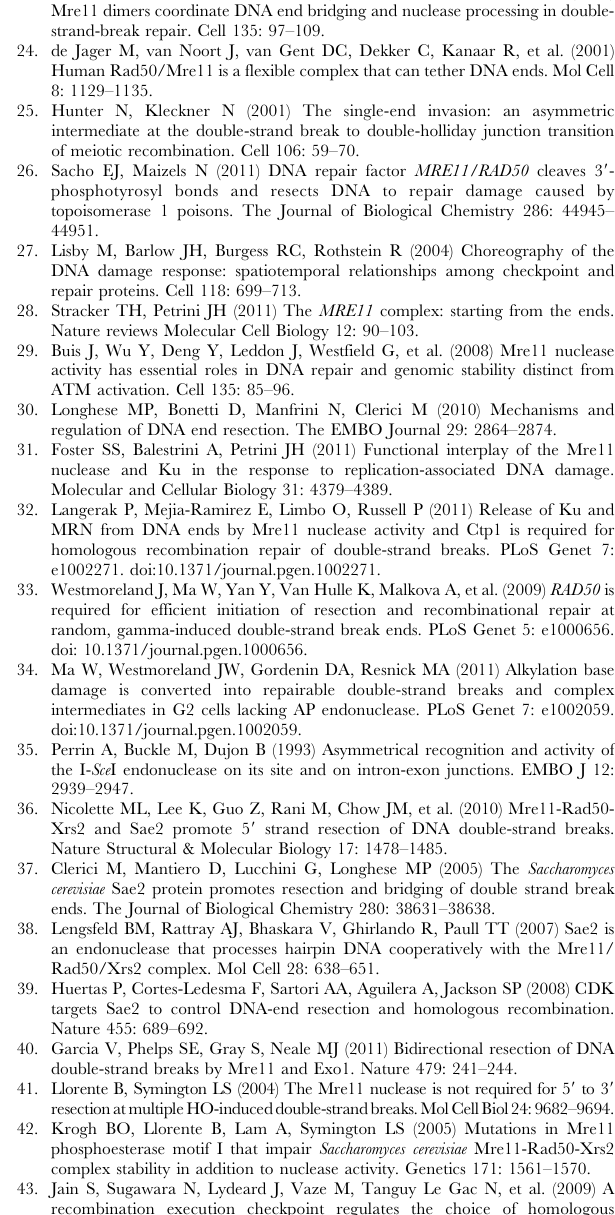
Figure S4 1-end resection of I- Sce I-induced breaks in D rad50 D ku70 cells. 2D-PFGE analysis of D rad50 and D rad50 D ku70 using ‘‘right’’ fragment probe. The lower spot under the m* position confirms that even in the absence of Ku complex, structural MRX is required for coincident resection at an I- Sce I-induced DSB. Note: D rad50 is also included in Figure 2D and is shown here for comparison. Table S1 Primers used for preparation of probes used in Southerns. Primer pairs were used for PCR amplification of genomic DNA. The appropriate PCR products were labeled with 32 P-dCTP by random priming as described in [48]. The Cha1 primers were used for labeling of the circular chromosome 3 for IR-induced DSBs. Primers in the III45.5 to III50 series were used for preparation of probes specific for the left fragment of the I-